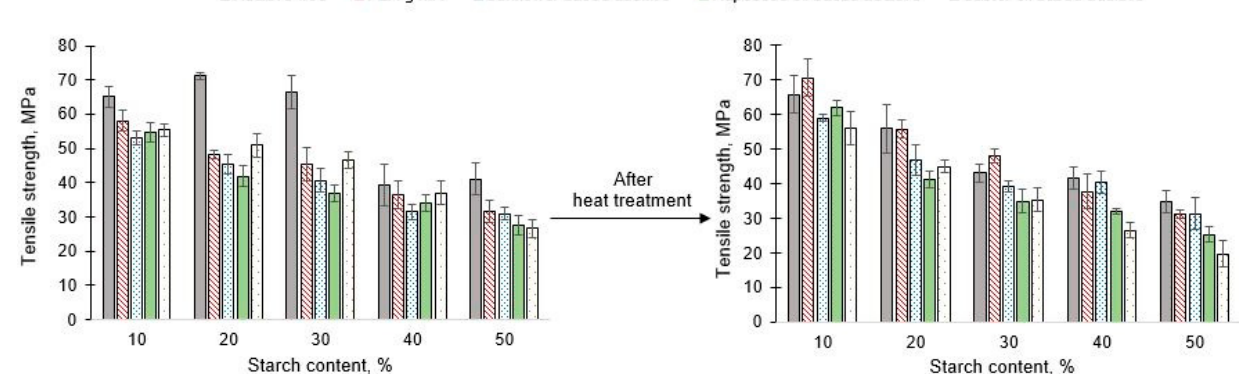
Figure 6. Tensile strength of unconditioned and conditioned PLA/starch blends.